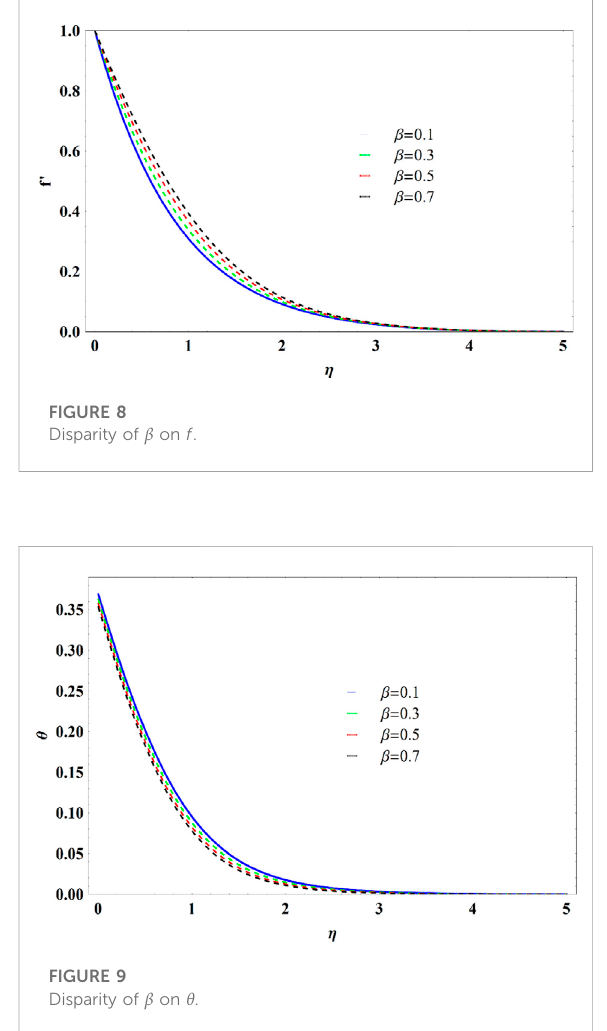
FIGURE 9 Disparity of β on θ .